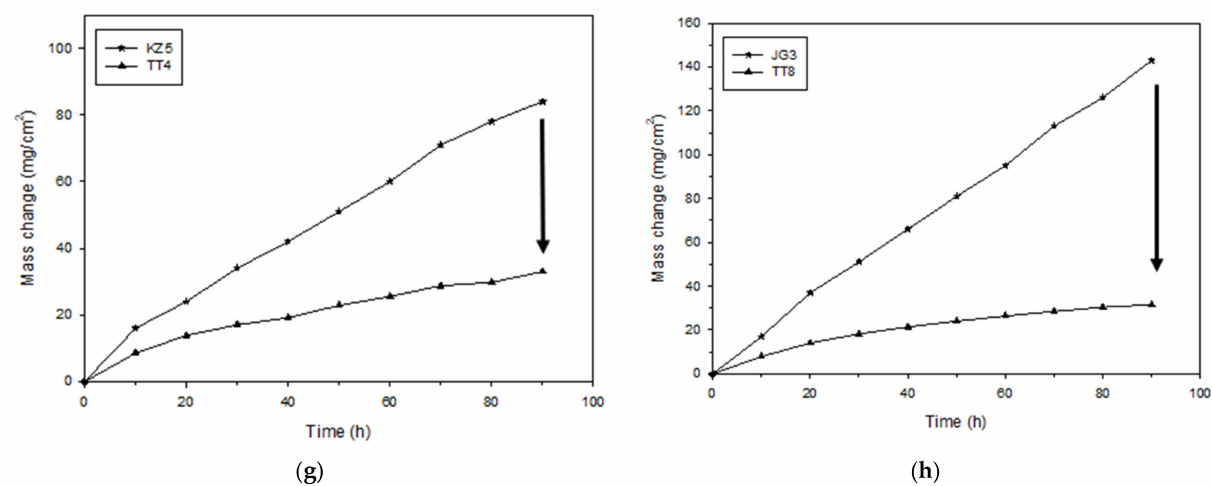
Figure 12. Comparison of mass changes of B-containing alloys TT2, TT3, TT4 and TT8 with reference alloys KZ4, KZ5, KZ7 and JG3. For isothermal oxidation at 800 and 1200 ◦ C. Arrows indicate direction of mass change at 800 ◦ C ( a – d ) and 1200 ◦ C ( e – h ).